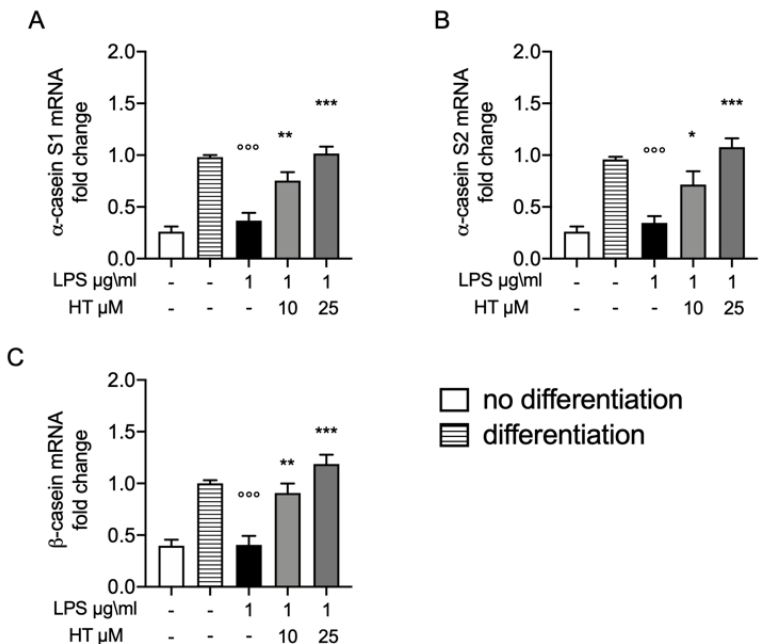
Figure 6. ( A ) Protective e ff ect of HT on casein stimulation in LPS stimulated MAC-T di ff erentiated cell: mRNA levels of α -casein S1; ( B ) α -casein S2 and ( C ) β -casein. Data representative of at least three experiments, means ± SEM; ◦◦◦ p < 0.001 vs. control di ff erentiated; * p < 0.05 vs. LPS; ** p < 0.01 vs. LPS; *** p < 0.001 vs.